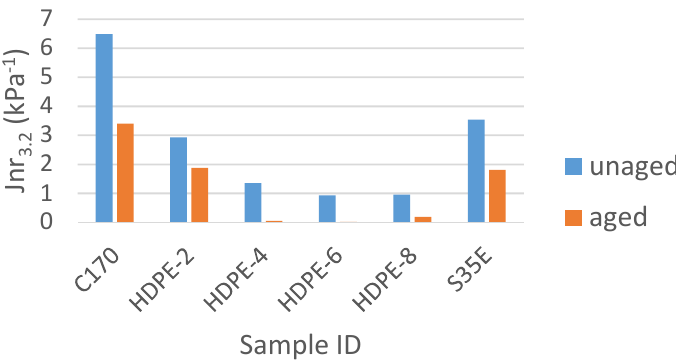
Figure 7. Impact of aging on non-recoverable compliance of different binders.